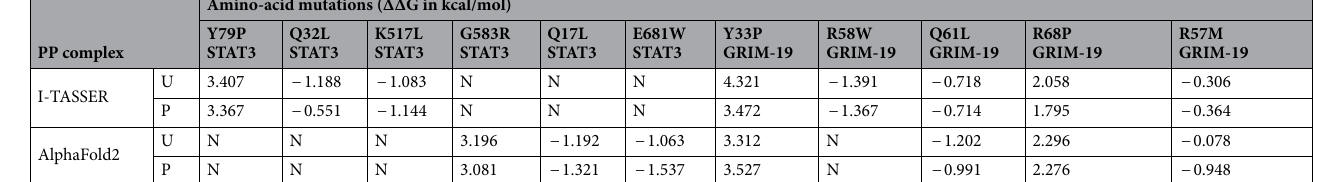
Table 3. Binding free energy change (ΔΔG) values upon mutation of select residues, of interface residues involved in hydrogen bonding upon mutation to all other amino acids using SSIPe. Positive values indicate decrease in binding affinity. N not found in hydrogen bonds calculated by Discovery Studio, U Unphosphorylated STAT3-GRIM-19, P Phosphorylated